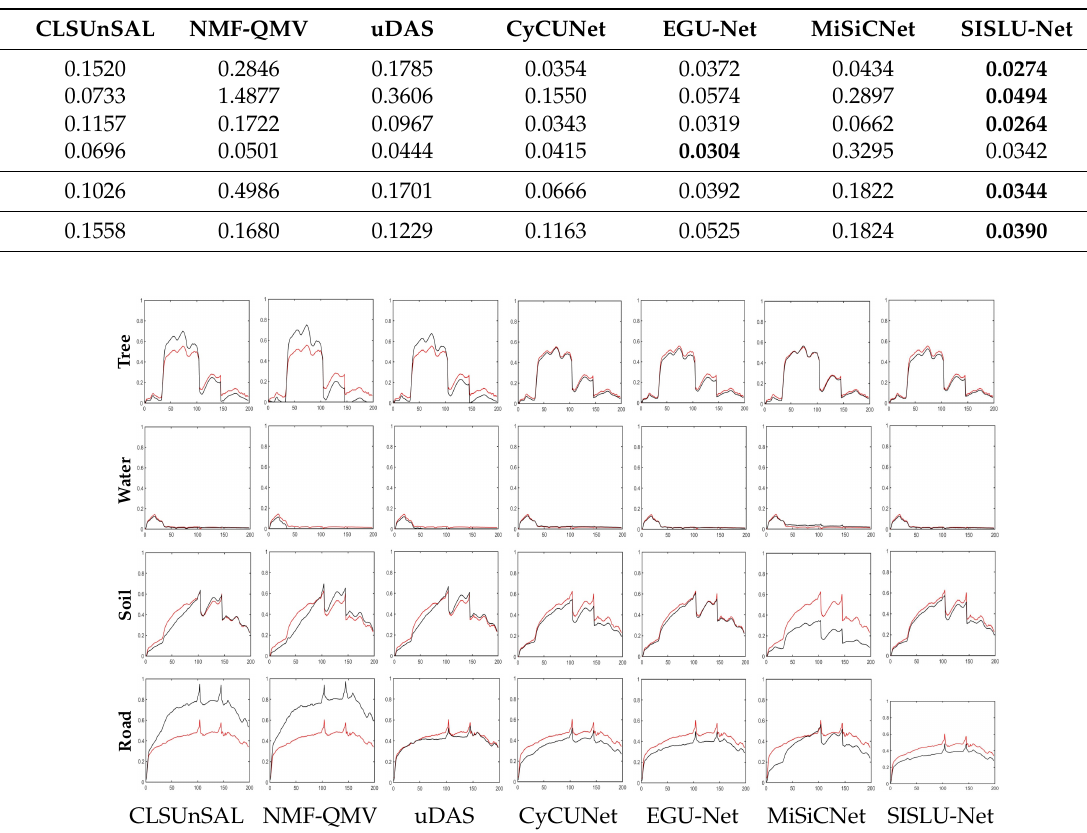
Table 9. Quantitative metrics for unmixing on the Jasper Ridge Dataset, including the SAD for each material, the mean SAD and RMSE. The optimal values are shown in bold.